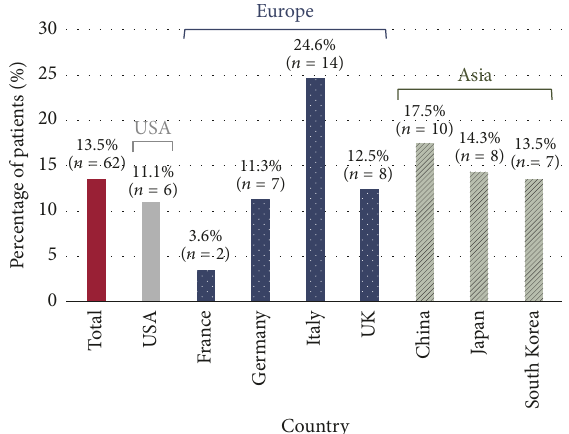
Figure 3: Occurrence of postoperative anastomotic leaks, overall (N = 458 ) and by country . Percentages and absolute numbers of patients with postoperative anastomotic leaks. Percentage for each country based on number of patients per country. Further details provided in Supplemental Table 6 . 𝑁 : total number of patients; 𝑛 : number of patients observed per